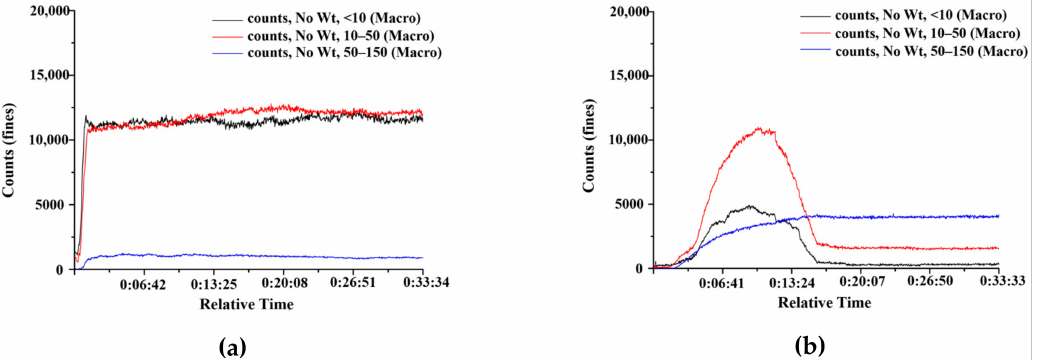
Figure 2. The variation curve of chord length of ERL MPs in ( a ) Water and ( b ) SOL